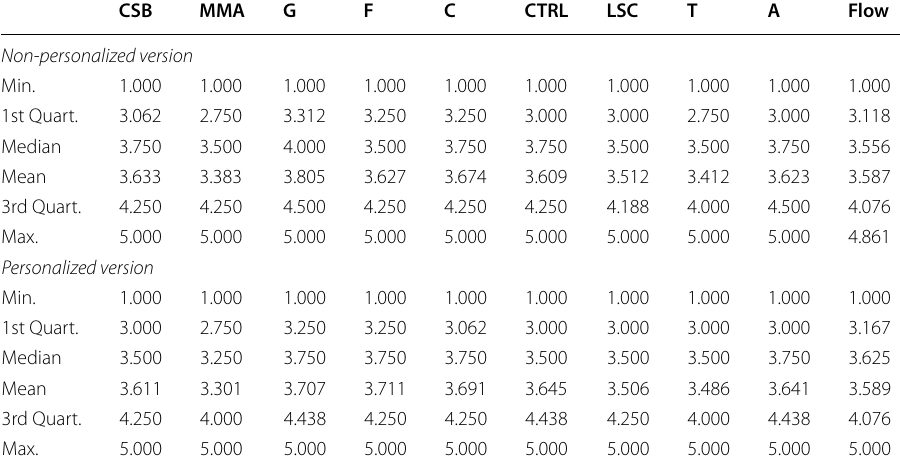
Table 5 Five number